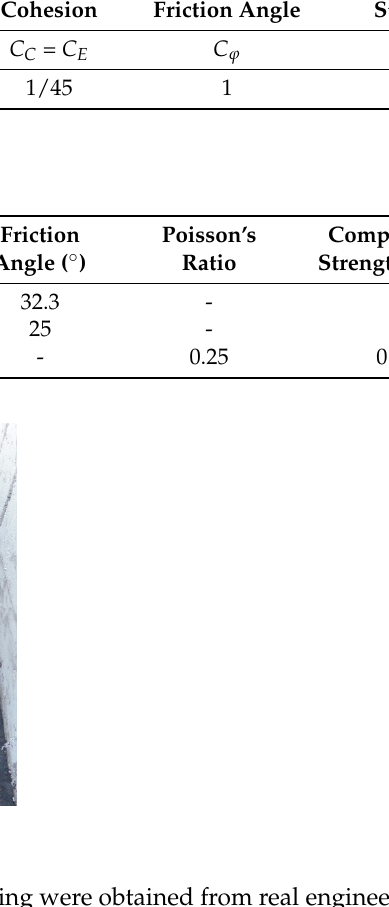
Figure 10. Jointed lining segments.